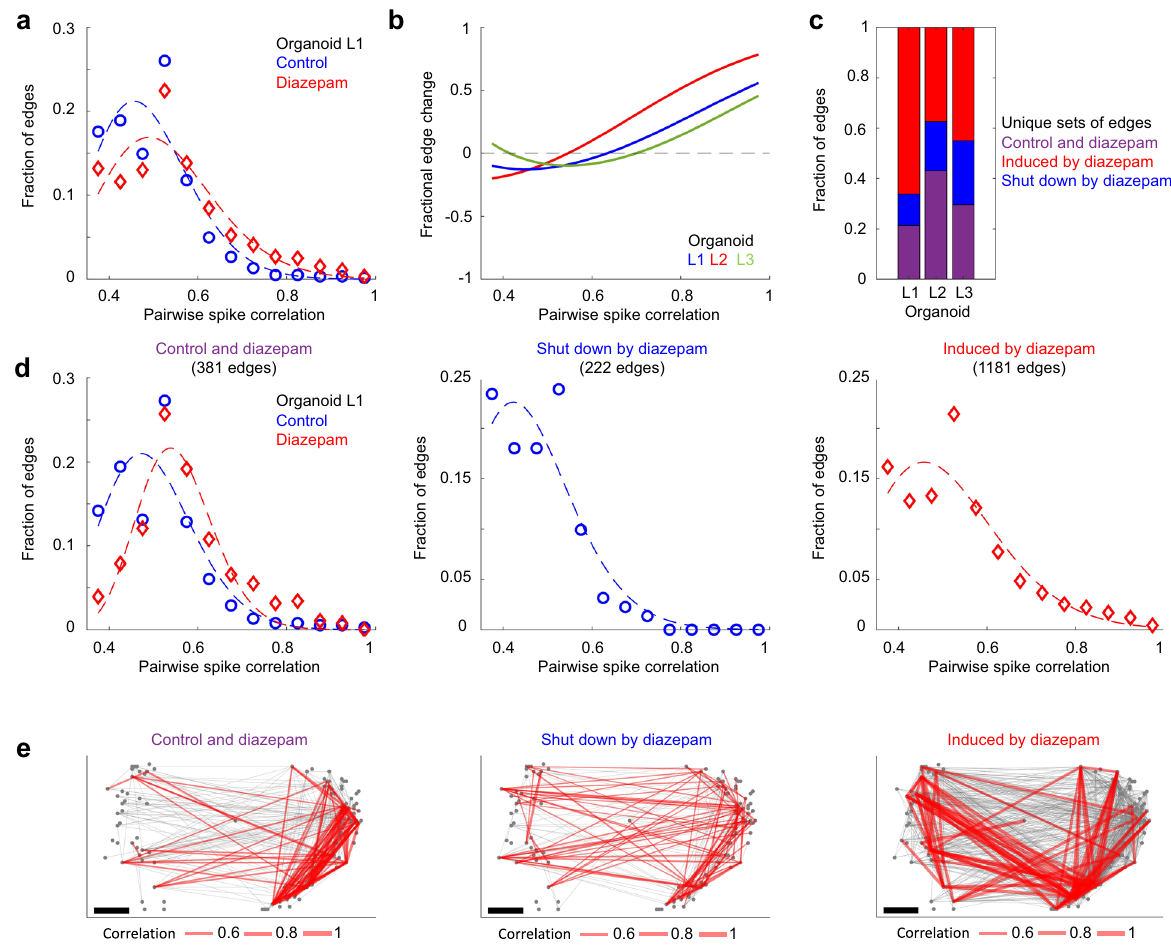
Fig. 6 | Diazepam selectively modulates the skeleton network of strong edges. a Pairwisespikecorrelation(edge)distributionsareshownfromthespatialmapsof Fig. 5c, e. The edge strengths (of the largest component of interconnected nodes) were binned using a bin size=0.05 over a connectivity range from 0.35 to 1. A gammadistribution fi tillustrates “ askeletonofstrongerconnectionsimmersedina sea of weaker ones ” . Diazepam (50 µ M) increased the minority population of stronger edge strengths, while decreasing the strength of the more abundant weakeredgeswithrespecttocontrolconditions. b Thefractionaldifferenceinedge strengths, ( f d − f c )/( f d + f c ),is shown, where f c and f d arethe gamma distribution fi ts